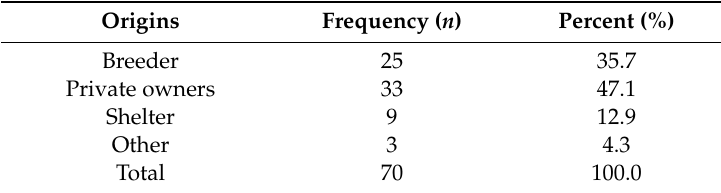
Table 9. Origins of dogs aggressive towards other dogs.